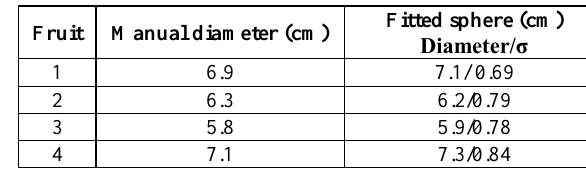
Table 5. Orange diameters manually measured in the generated point cloud and diameters obtained from the fitted